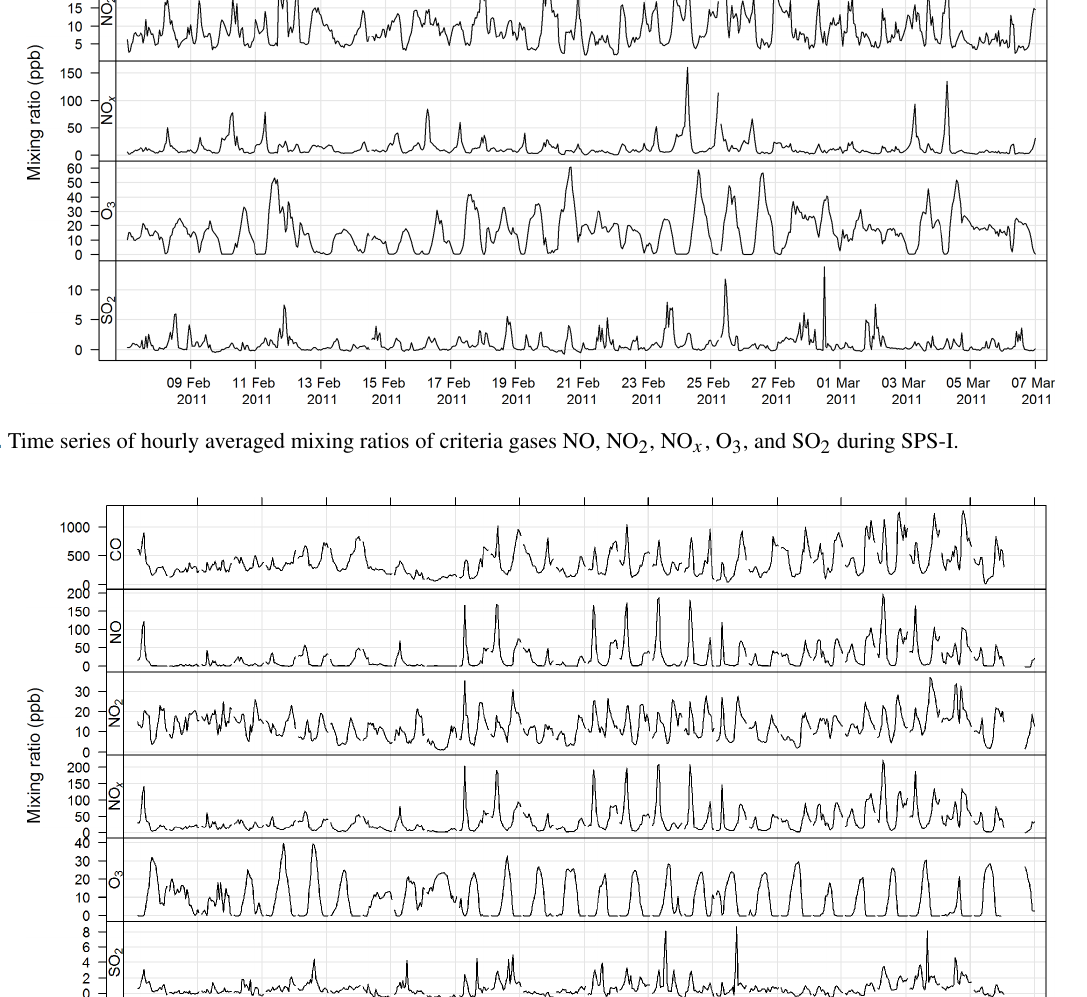
as a function of wind direction for SPS-I and SPS-II are shown in Fig.